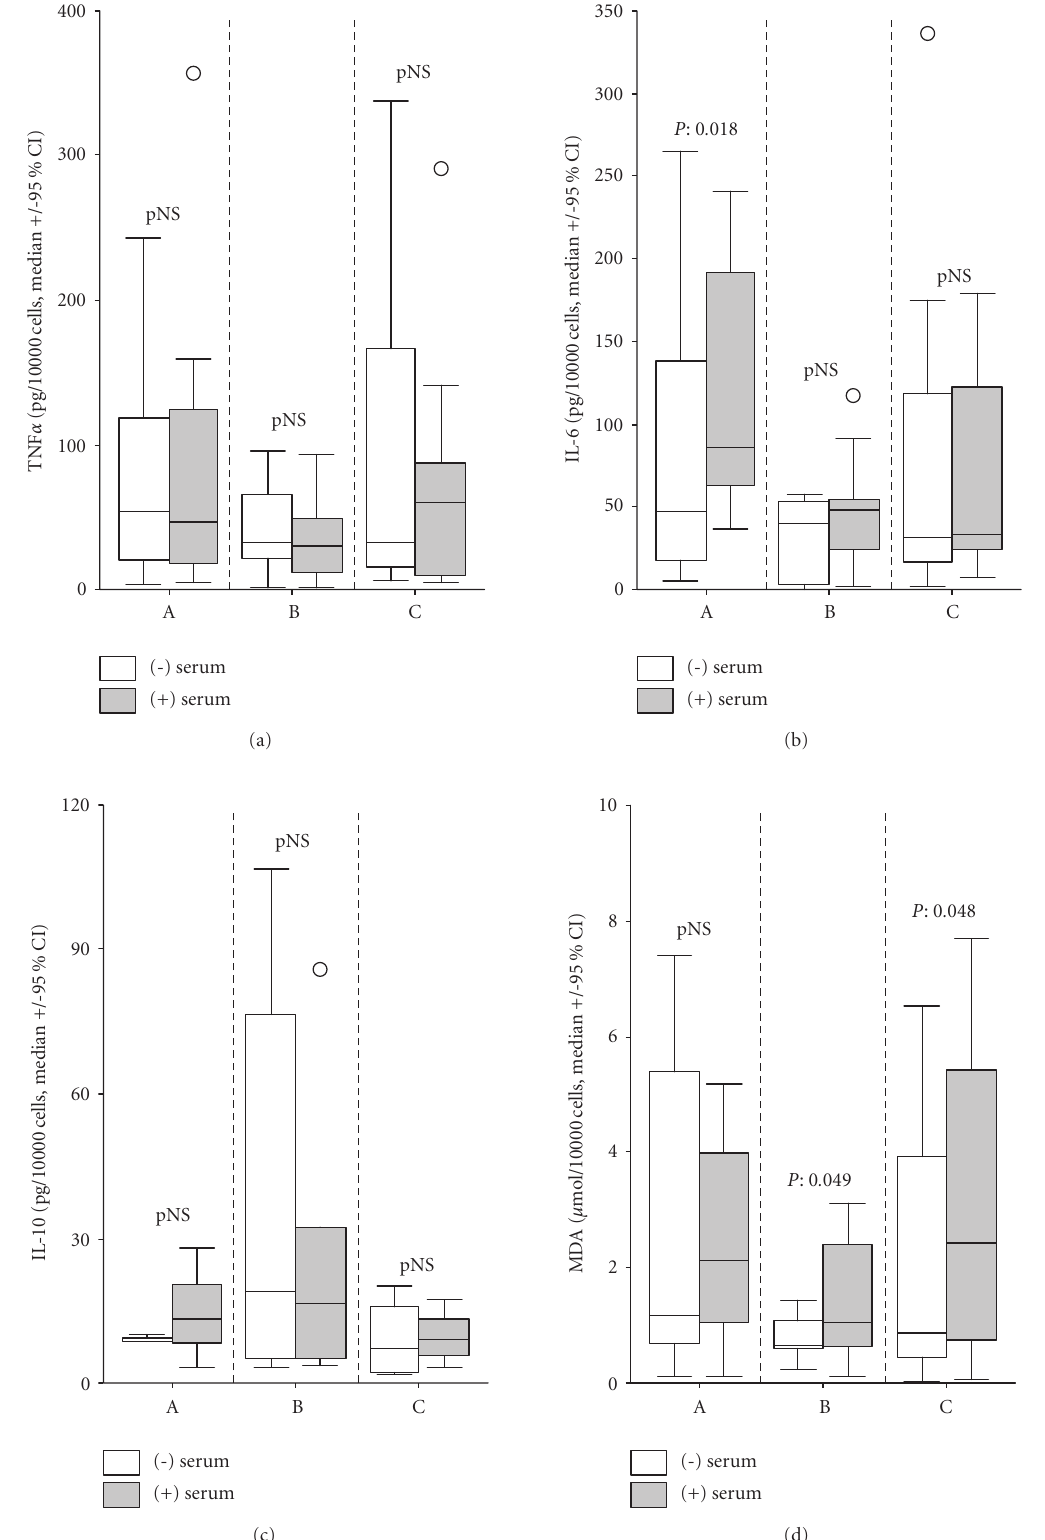
Figure 2: E ff ect of serum on ex vivo release of tumour necrosis factor-alpha (TNF α ), IL-6, IL-10, and malondialdehyde (MDA) by monocytes of 51 patients with septic syndrome. Patients were divided into three groups depending of the time lapsing between blood sampling and advent of fever: group A: < 12 hours, group B: 12–24 hours, and group C: > 24 hours. Circles denote